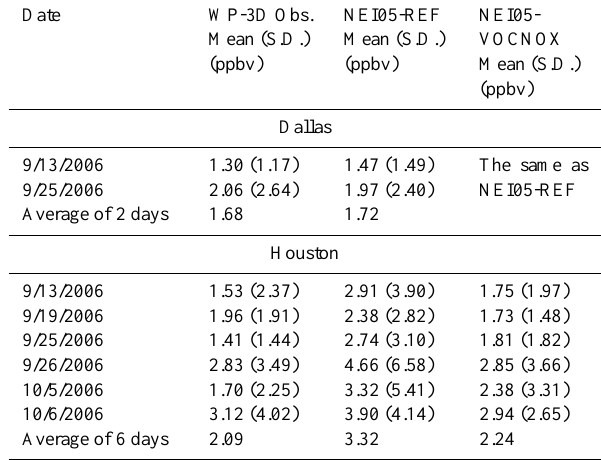
Table 5. Mean and standard deviation of WP-3D observed and modeled NO 2 using the NEI05-REF and NEI05-VOCNOX invento- ries for the Dallas-Fort Worth and Houston-Galveston source boxes. See Table 4 for geographic definition of these source boxes. S.D. = standard